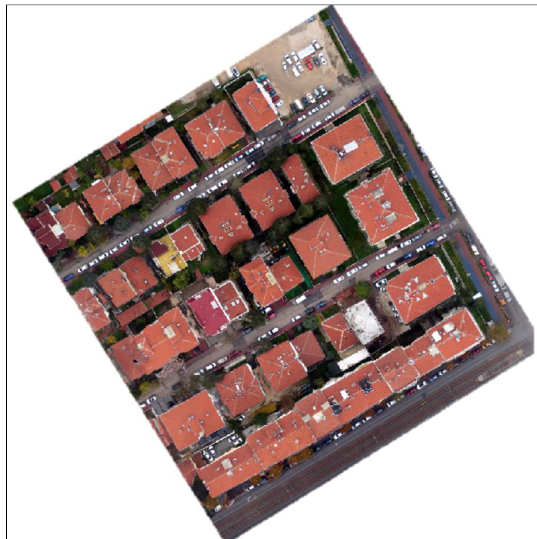
Figure 1: Orthomosaic images of the study area